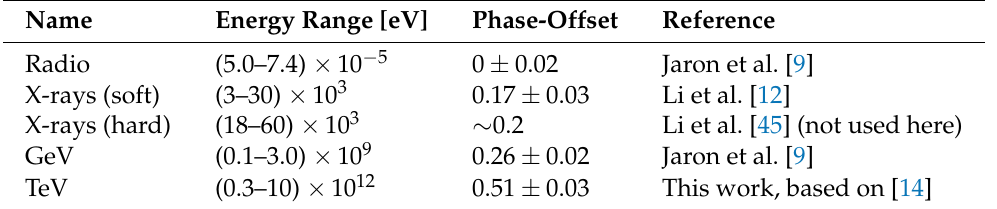
Table 2. Phase-offsets of the long-term modulation, as observed at different wavelengths of the emission from LS I +61°303. All phase-offset values are given relative to the long-term phase of the radio emission. The higher energy emission lags the radio in terms of